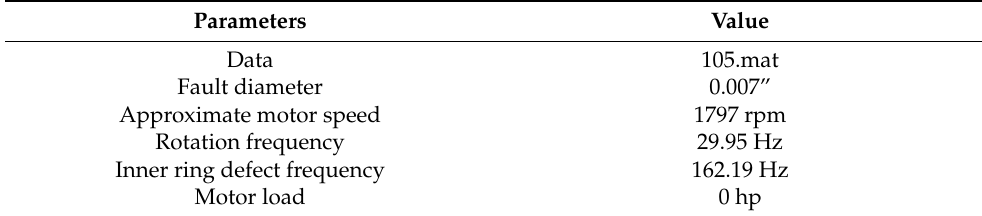
Table 2. the specific technical parameters of analyzed